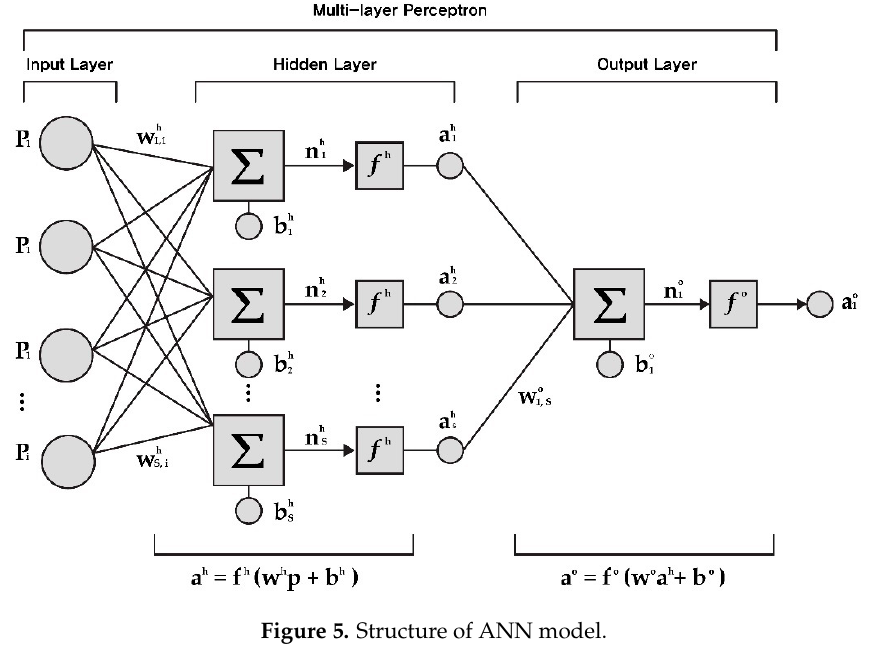
Figure 5. Structure of ANN model .